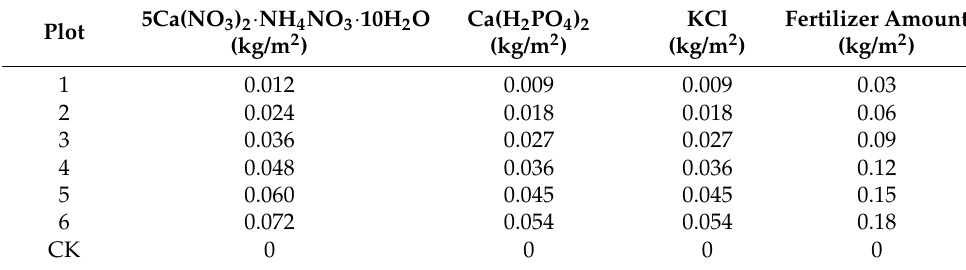
Table 1. Fertilization scheme for six plots.